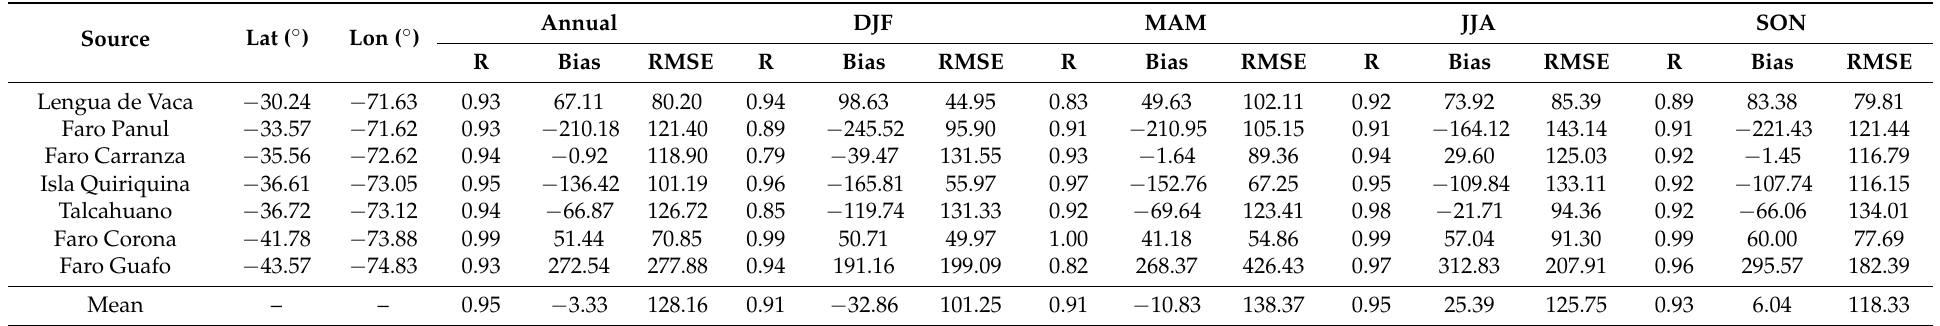
Table 3. Statistics from SLP data comparison between reanalysis and